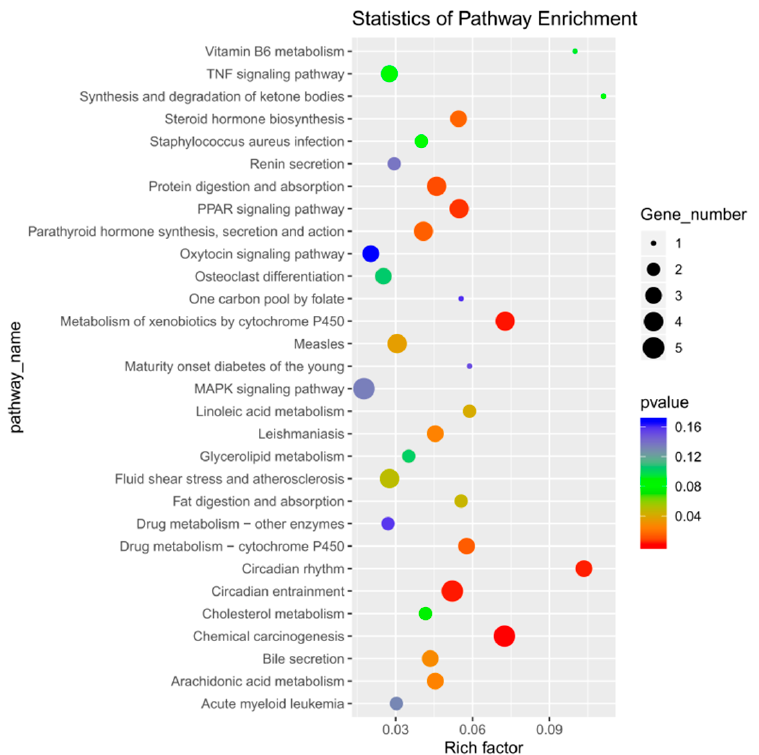
Figure 5. Bubble diagram of DEGs KEGG enrichment analysis. DEGs: differentially expressed genes; KEGG: Kyoto Encyclopedia of Genes and Genomes.